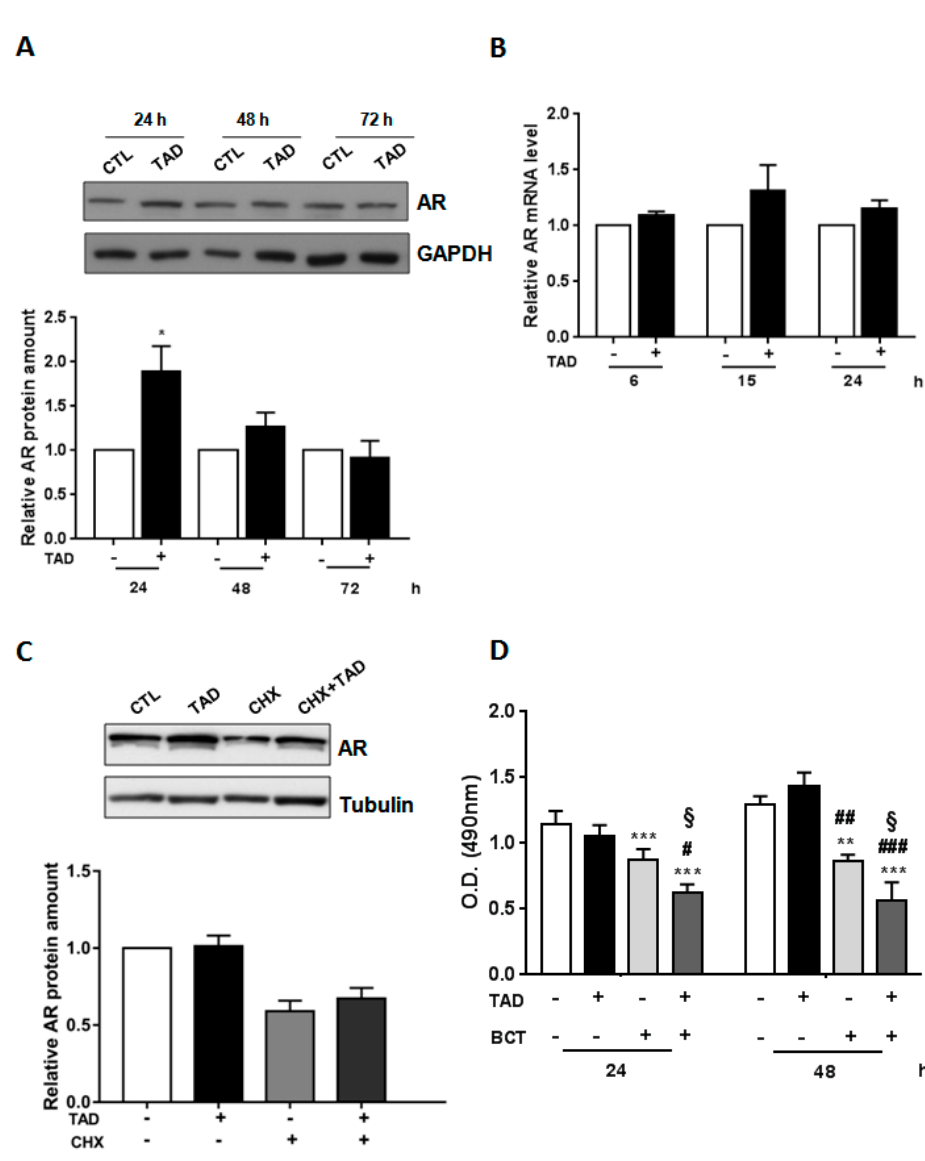
Figure 1. Effects of TAD on AR expression and LNCaP proliferation. ( A ) Representative Western blot analysis of AR protein expression in LNCaP cells cultured in the presence (+) or in the absence ( − ) of TAD (10 − 6 M) for 24, 48 and 72 h. GAPDH was used as an internal control for protein loading. ( B ) Effect of TAD on AR mRNA expression in the presence (+) or in the absence (-) of TAD (10 − 6 M). ( C ) CHX effect on AR protein expression. A representative Western blot of AR protein expression is shown in LNCaP cells cultured for 3 h in the presence (+) or in the absence ( − ) of TAD (10 − 6 M), and pretreated or not with CHX (10 µ g/mL) for 1 hr. Tubulin, control for protein loading. ( D ) MTS proliferation assay in LNCaP cells in cultured cells either in the presence (+) or in the absence ( − ) of TAD (10 − 6 M) and/or bicalutamide (BCT, 10 − 4 M) for and 24–48 h. Results are represented as mean ± SE ( n = 3) of three independent experiments. * p < 0.05, ** p < 0.005, *** p < 0.001 vs. CTL cells, # p < 0.05, ## p < 0.005, ### p < 0.001 vs. TAD treated cells, § p < 0.05 vs. BCT treated